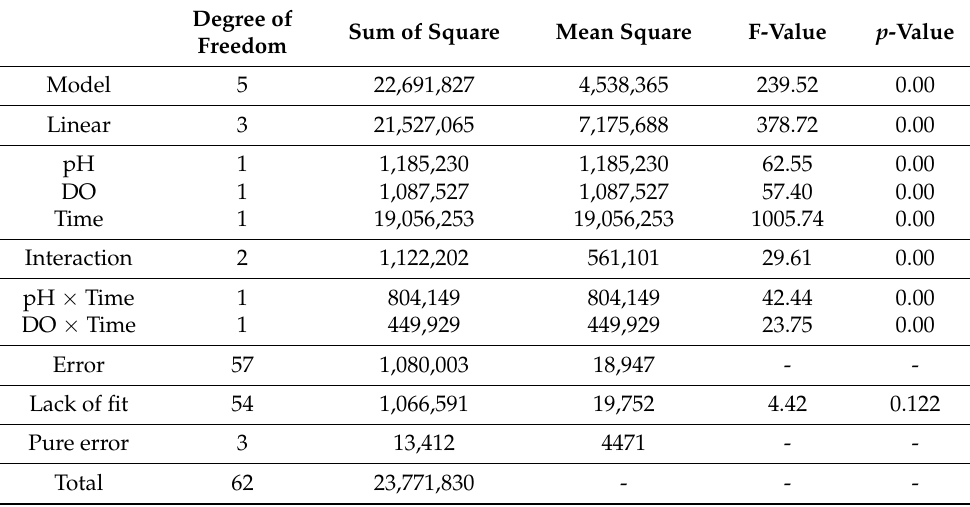
Table 6. Analysis of variance findings for the derived corrosion depth